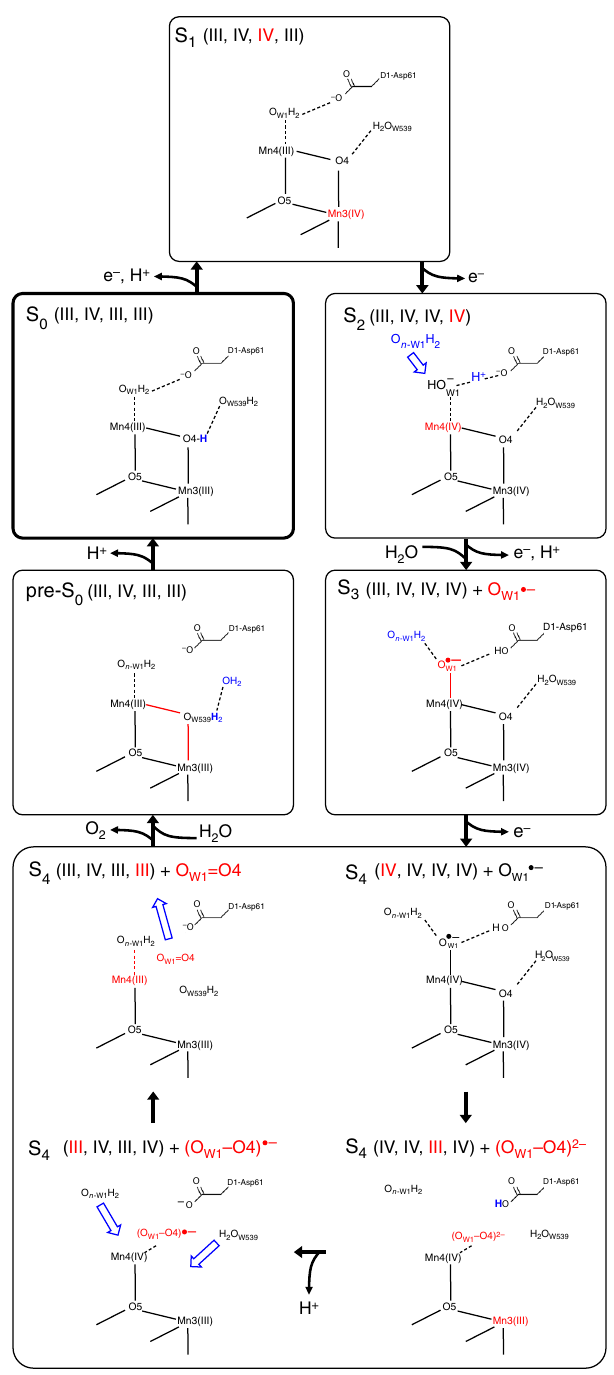
Fig. 8 Mechanism of O 2 formation and recovery of Mn 4 CaO 5 . S 0 is the lowest oxidation state. In the S 0 -to-S 1 transition, a low-barrier H-bond between OH – at O4 and W539 (as indicated in the crystal structure 9 ) releases the proton via the O4-water chain 4 . In the O4-water chain, the pre-PT pattern transforms into the post PT pattern as a result of proton transfer. In the S 1 -to-S 2 transition, oxidation of Mn4(III) to Mn4(IV)